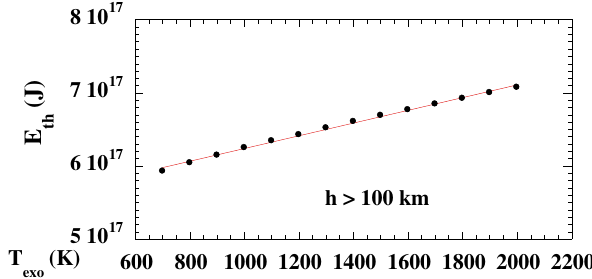
Fig. 4. E th estimated from J77 tables plotted as a function of globally-averaged exospheric